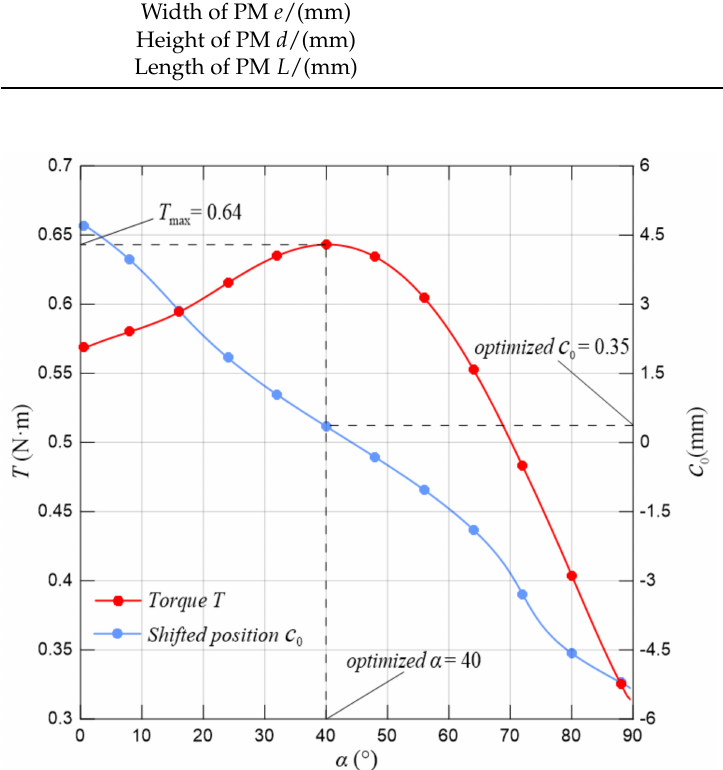
Figure 12. Relationship between c 0 , α and T max